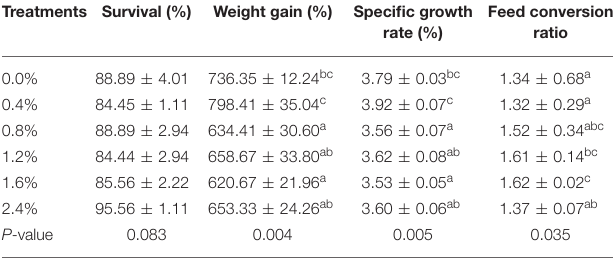
Numbers in the same column with different superscripts are significantly different (P < 0.05). Values of survival, weight gain, specific growth rate and feed conversion ratios (mean ± S.E.) are the mean of three replicate